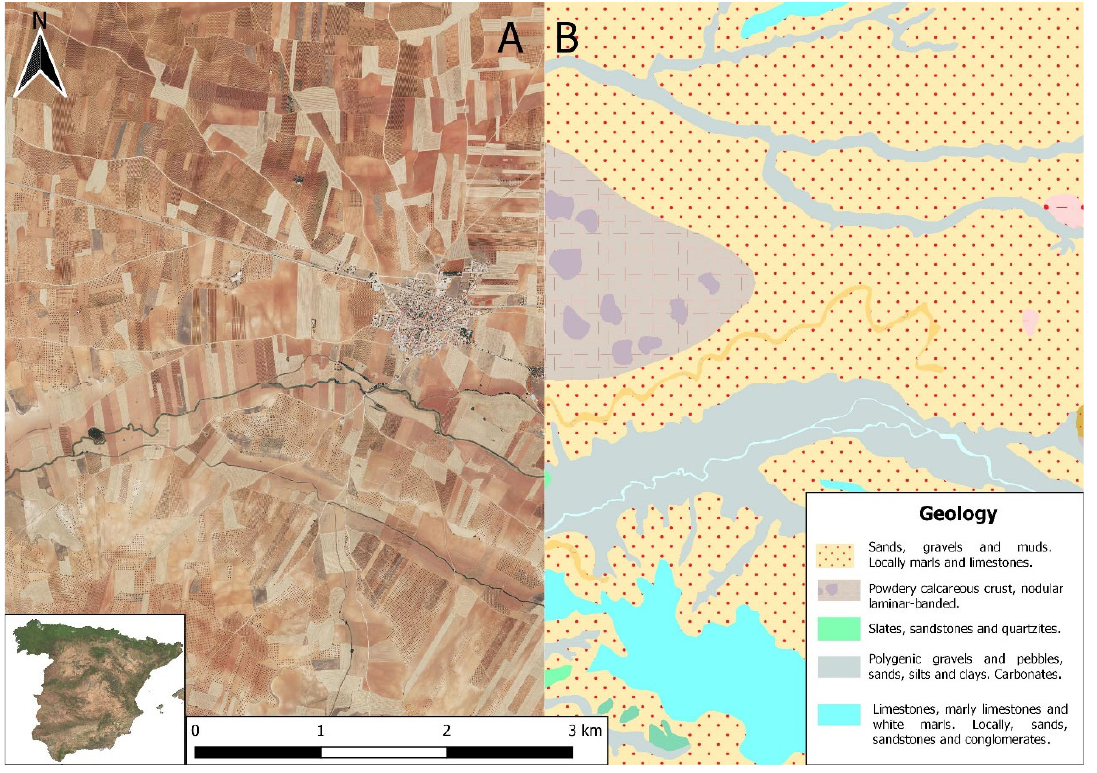
Figure 1. Location of the study area. ( A ) Satellite image from the National Aerial Orthophotography Plan (PNOA) corresponding to the area. ( B ) Representation with the same scale where the geomor- phological units that make up the landscape are represented: Source: Instituto Geológico y Minero de España (IGME).